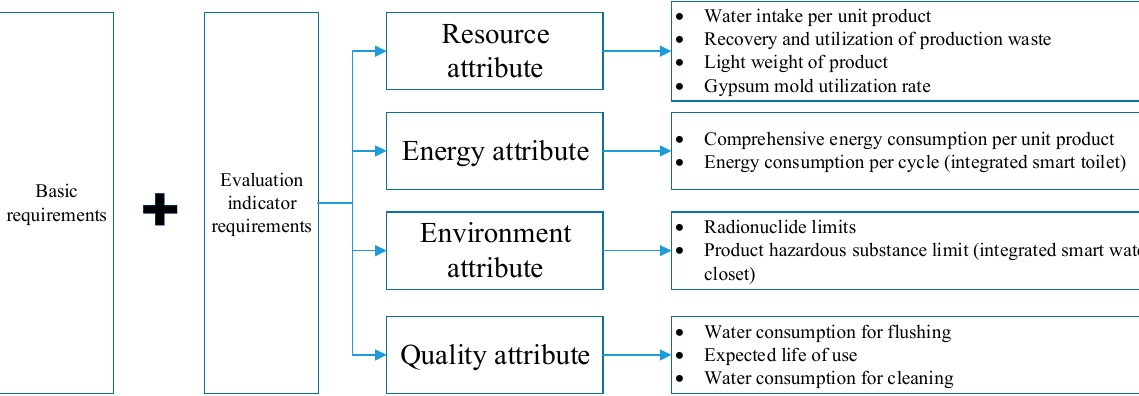
Figure 3. Construction of green evaluation system.